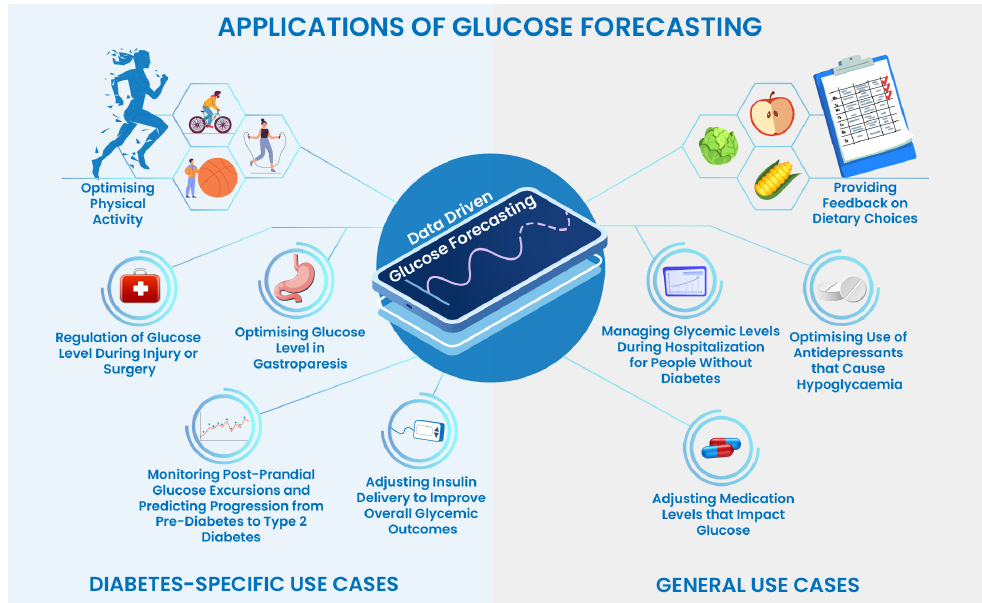
Figure 1. Applications and use cases of data-driven glucose profile forecasting in general healthcare and diabetes-specific